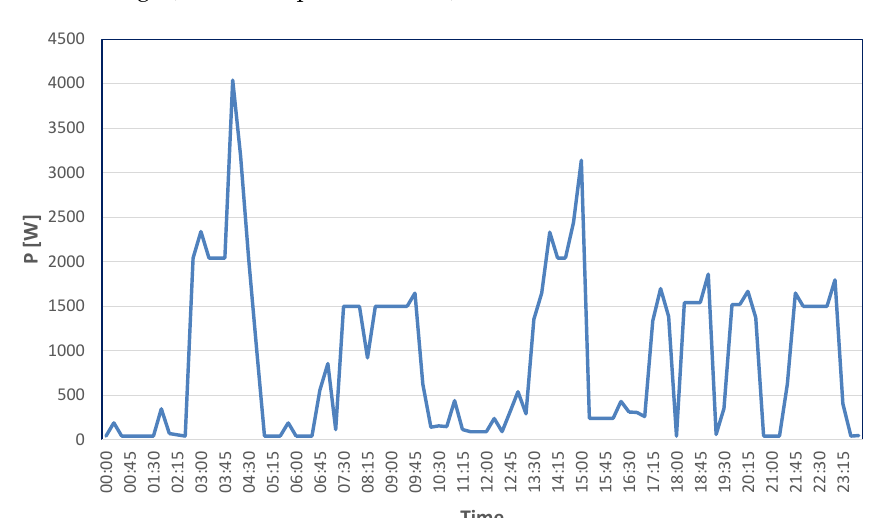
Figure 5. Residential user’s power profile.